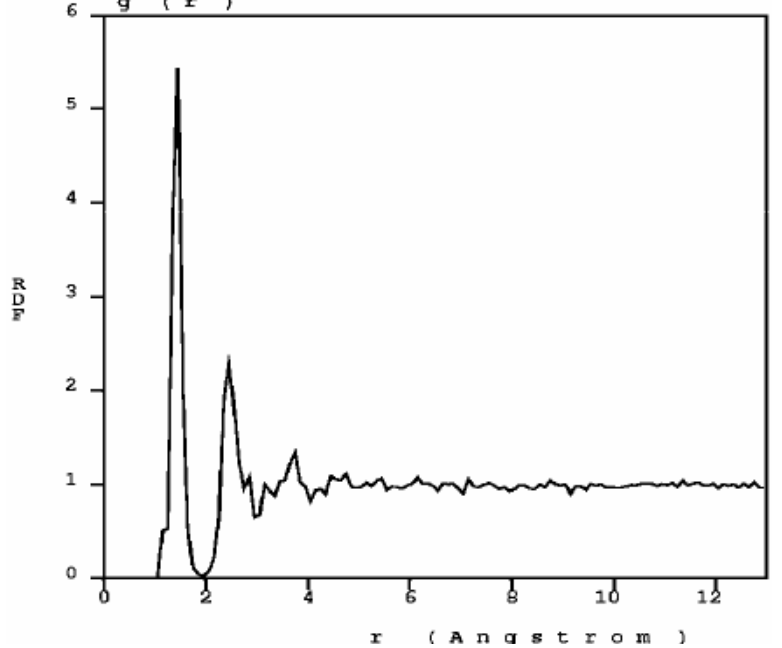
Figure 1. The atomic topology (RDF) for nanoporous carbon is more typical of an amorphous (porous) sample. There are three well defined peaks, and a minimum between the first and the second peaks as in typical amorphous materials [23].